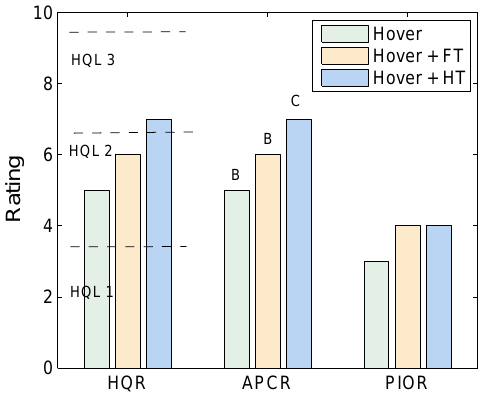
Figure 21. Comparison of results obtained from three hover manoeuvres completed using the same